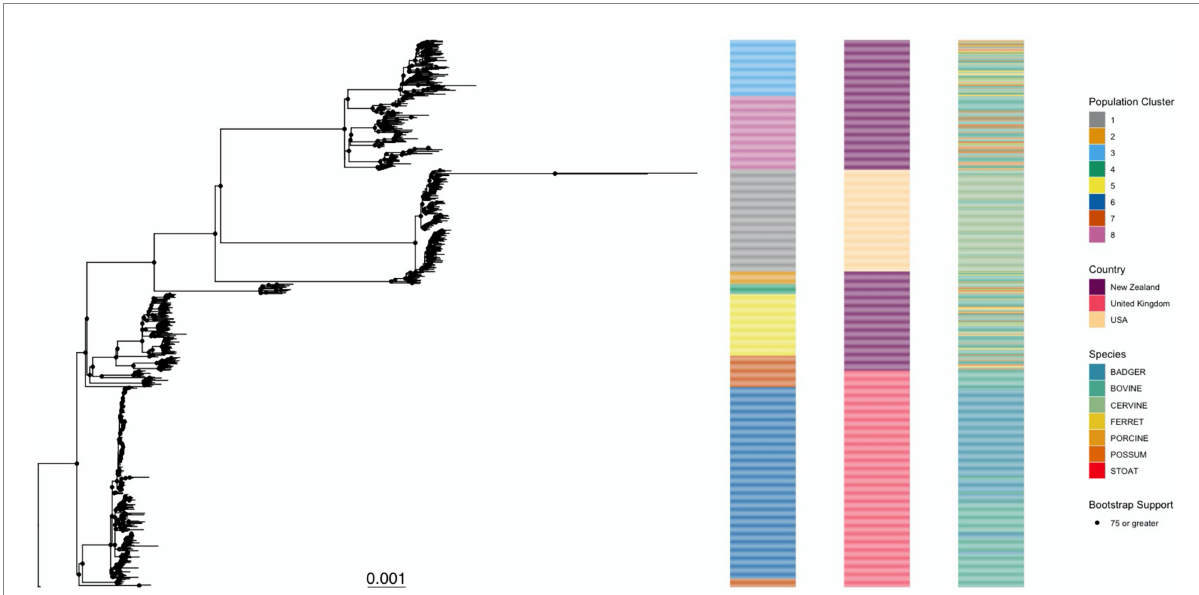
FIGURE 3 Mycobacterium bovis maximum likelihood phylogenetic tree. This tree was inferred from the 6,847 SNPs of 700 Mycobacterium bovis isolates extracted from three independent studies in endemic regions: New Zealand, United Kingdom, and the United States of America. The TPM2+F+R4 substitution model was the one with best statistical support (by Bayesian Information Criteria). Ultrafast bootstrap support for the internal nodes is indicated by a black circle, its presence indicating that the node has support of >75%. The phylogeny is further annotated by the taxa’s membership in a population cluster (left), country of origin (middle), and host species (right). The tree was rooted using the M. bovis reference genome AF2122/97 as an